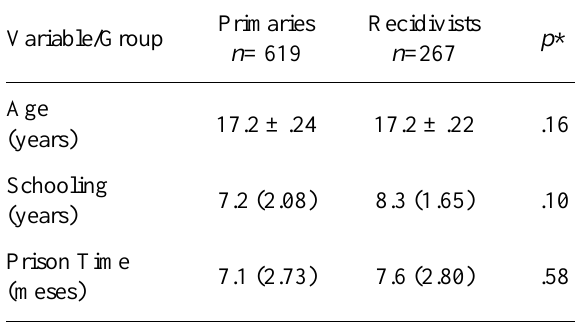
Socio-Demographic Data for Both Groups. Test